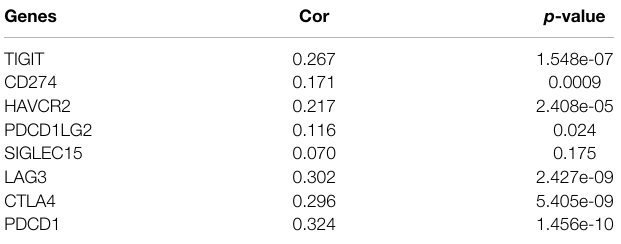
TABLE 2 | Correlation of KIFC1 with immune checkpoints in LIHC. Genes Cor p -value TIGIT